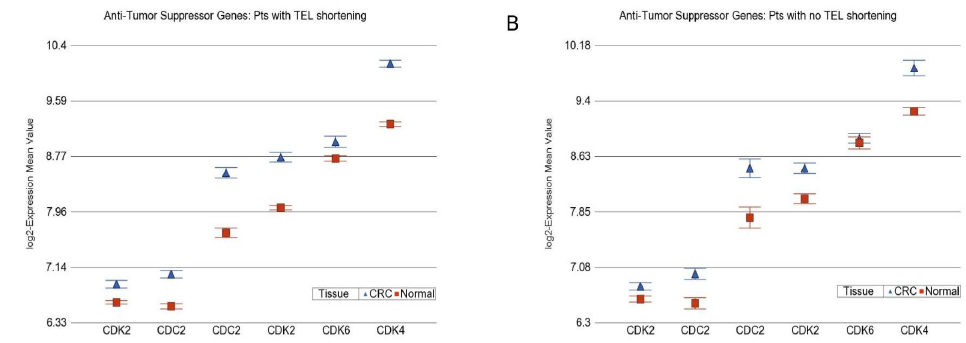
Figure 5. Differential gene expression of antitumor suppressor genes (cyclin D kinase) in CRC tissue (in blue) compared to corresponding normal tissue (in red). The gene probes (multiple probes for some genes) are shown on the x-axis, and the Log 2 -transformed expression value is shown on the y-axis. CDC2 is also known as CDK-1. Data from patients with RTL shortening are shown on the left ( A ), and data from patients without RTL shortening are shown on the right ( B ). The average magnitude of overexpression was significantly higher ( p = 0.003) if the patient had telomere shortening (1.52-fold (95% CI 1.46 – 1.59), shown in A ) compared to those without telomere shortening (1.35-fold (95%CI 1.26 − 1.43), shown in B ).